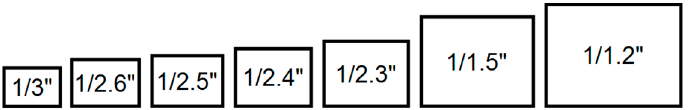
Figure 6. Examples of different complementary metal oxide semiconductor (CMOS) sensor sizes used in current mobile phone cameras.